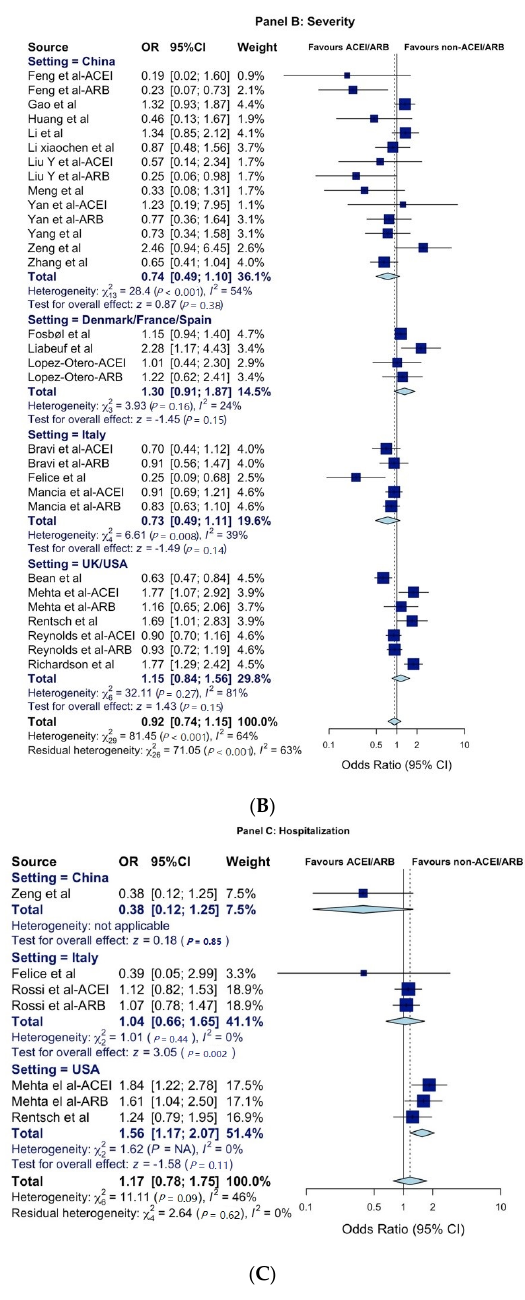
Figure 2. Forest plots for country clusters ( A ) mortality, ( B ) severity of COVID ‐ 19 disease, and ( C ) hospitalization. All studies were published in 2020. All citations included in the Supplementary Materials file Appendix to Table S1. The size of squares is proportional to the weight of each study. Horizontal lines indicate the 95% CI of each study; diamonds, the pooled estimate with 95%